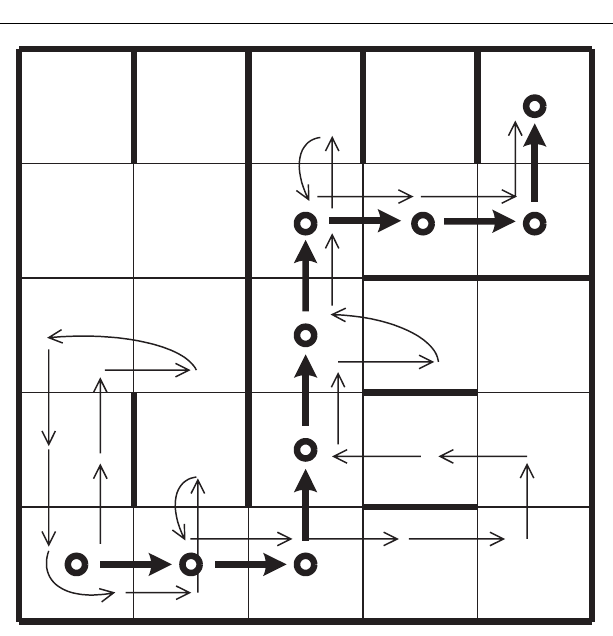
b is the number of incorrect predictions of a situation being neg-